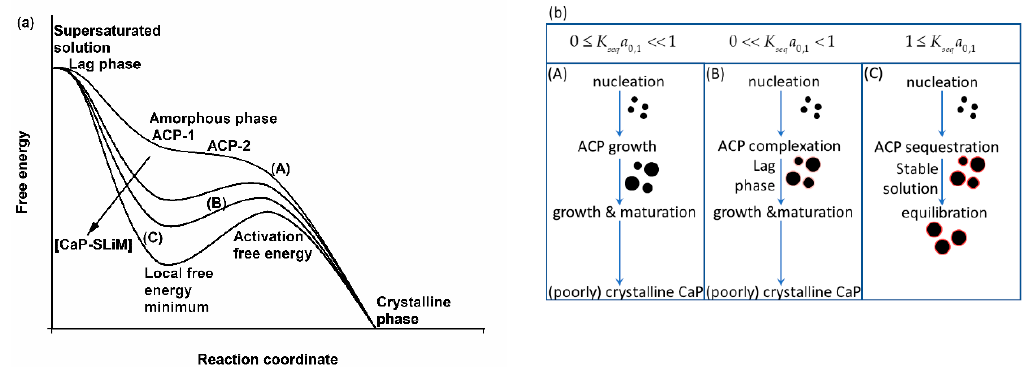
Figure 3. E ff ect of phosphopeptides on the free energy changes during the precipitation and maturation of CaP from a supersaturated solution. ( a ) In the absence of the phosphopeptide (curve A), nuclei of amorphous CaP form during the lag phase and grow into a precipitate of ACP-1 which matures into ACP-2, and further matures to form a poorly crystalline or crystalline phase. Adding a phosphopeptide at any point in the reaction up to the stage where the ACP begins to mature into a crystalline form generates a local free energy minimum (curves B and C) and an activation free energy barrier to slow or stop further maturation. The position of the minimum, the composition of the sequestered ACP and the size of the nanocluster particles depend on the a ffi nity of the phosphopeptide for the CaP ( K seq ), its concentration in the continuous phase at equilibrium ( a 0,1 ) and other factors. ( b ) The phosphopeptide can act as an inhibitor and as a nucleator of CaP precipitation, either increasing or decreasing the time spent in the lag phase, depending on which e ff ect predominates. For a given phosphopeptide the course of the reaction can be expressed in terms of the value of the product K seq a 0,1 . (A) Homogeneous nucleation in the presence of a non-binding phosphopeptide or heterogeneous nucleation at a very high molar ratio of CaP to phosphopeptide. E ff ectively, K seq a 0,1 << 1 (curve (A) in ( a )) and the ACP matures to form a (poorly) crystalline CaP. (B) An intermediate situation (0 < K seq a 0,1 < 1) (curve (B) in ( a )) in which competent sequestering phosphopeptides are present and form kinetically stabilized complexes with CaP to decrease (in this example) or increase the time spent in the lag phase, but the activation free energy barrier is not large enough to prevent further growth and maturation of the